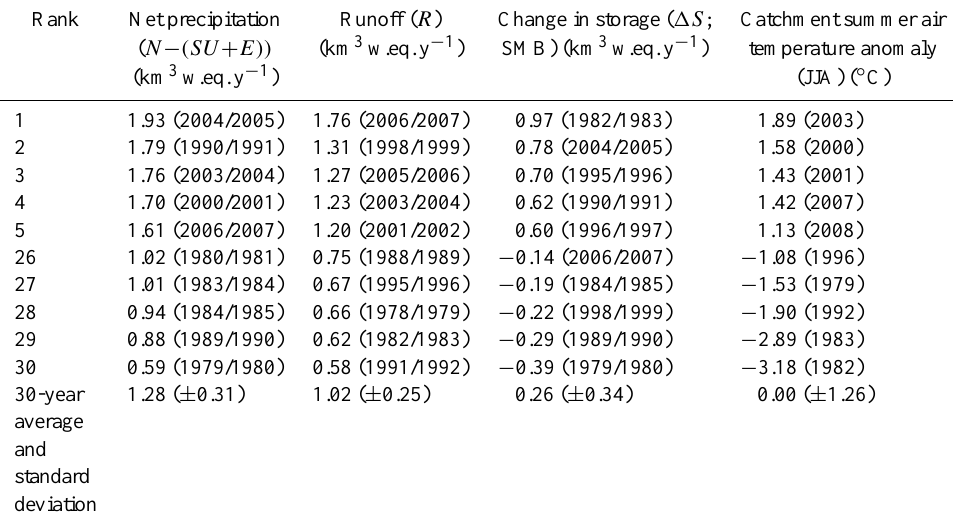
Table 4. Rank-ordered Kangerlussuaq catchment net precipitation (defined as P − (SU + ET )) , runoff ( R ), change in storage ( 1S ), and catchment summer (June, July, and August) air temperature anomaly for 1978/1979 through 2007/2008, where P is the precipitation input from snow and rain (and possible condensation), ET is evapotranspiration (liquid-to-gas phase (atmosphere) flux of water vapor), and SU is sublimation, including blowing-snow sublimation (snow blowing; solid-to-gas phase with no intermediate liquid stage). The yearly water balance equation for the catchment can be described by: P − (ET + SU) − R ± 1S =0 ± η . Here, η is the water balance discrepancy (error). Rank Runoff ( R ) Change in storage ( 1S